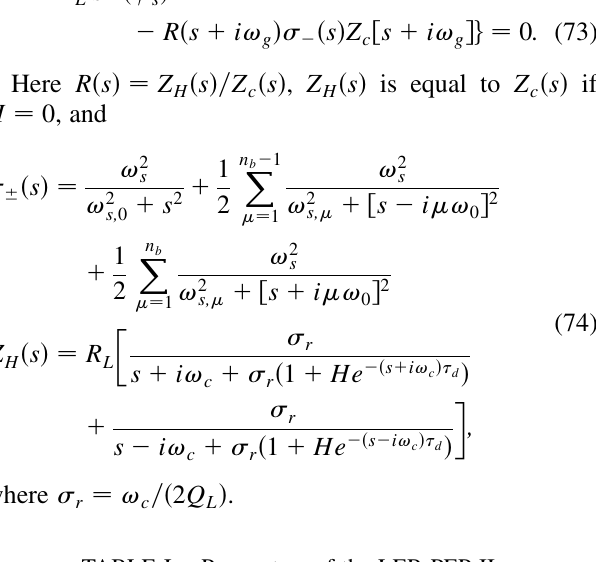
TABLE I. Parameters of the LER PEP-II.